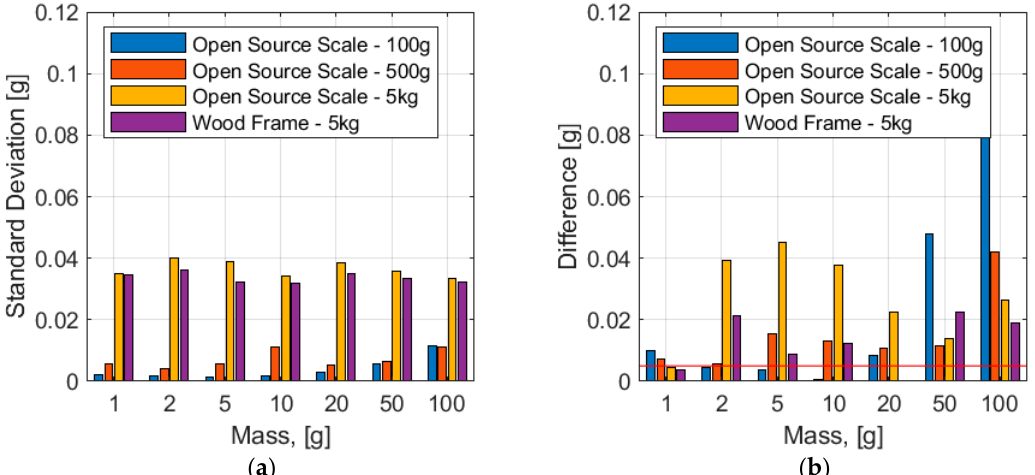
Figure 13. The standard mass test results are shown. ( a ) The standard deviation (sample of at least 48 measurements) increased with the range of the load cell; there is little difference between the PLA housing and wood frame. ( b ) The absolute value of the difference between the average measurements of each scale and the nominal mass of the weights is shown. The accuracy range for the weights is indicated by a red line. Table 4. The average standard deviation for each load cell during testing with standard masses is compared as a percentage of the load cell’s total range. These results reinforce the idea that the precision of the load cell is a function of its range and style.